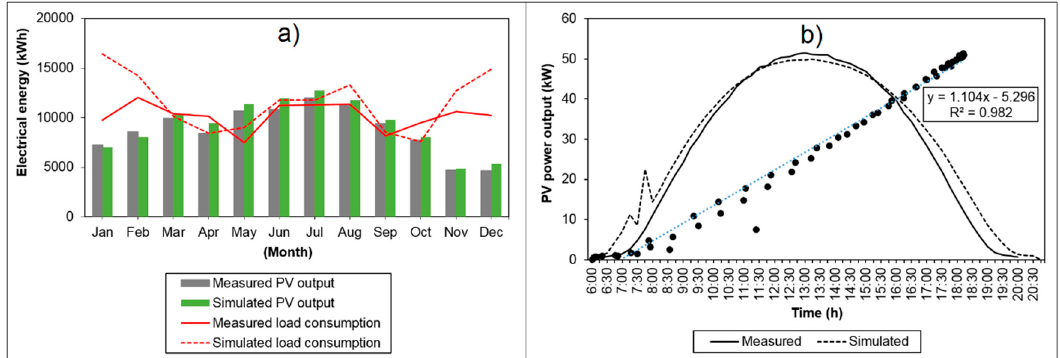
Figure A1. ( a ) Annual simulated and measured data comparisons of end-use load consumption and PV output in 2016; and ( b ) daily comparison of PV output. Installed PV power: 65.78 kW p . PV modules tilt angle: 30°. Weather file: Actual Meteorological Year of 2016 (AMY).